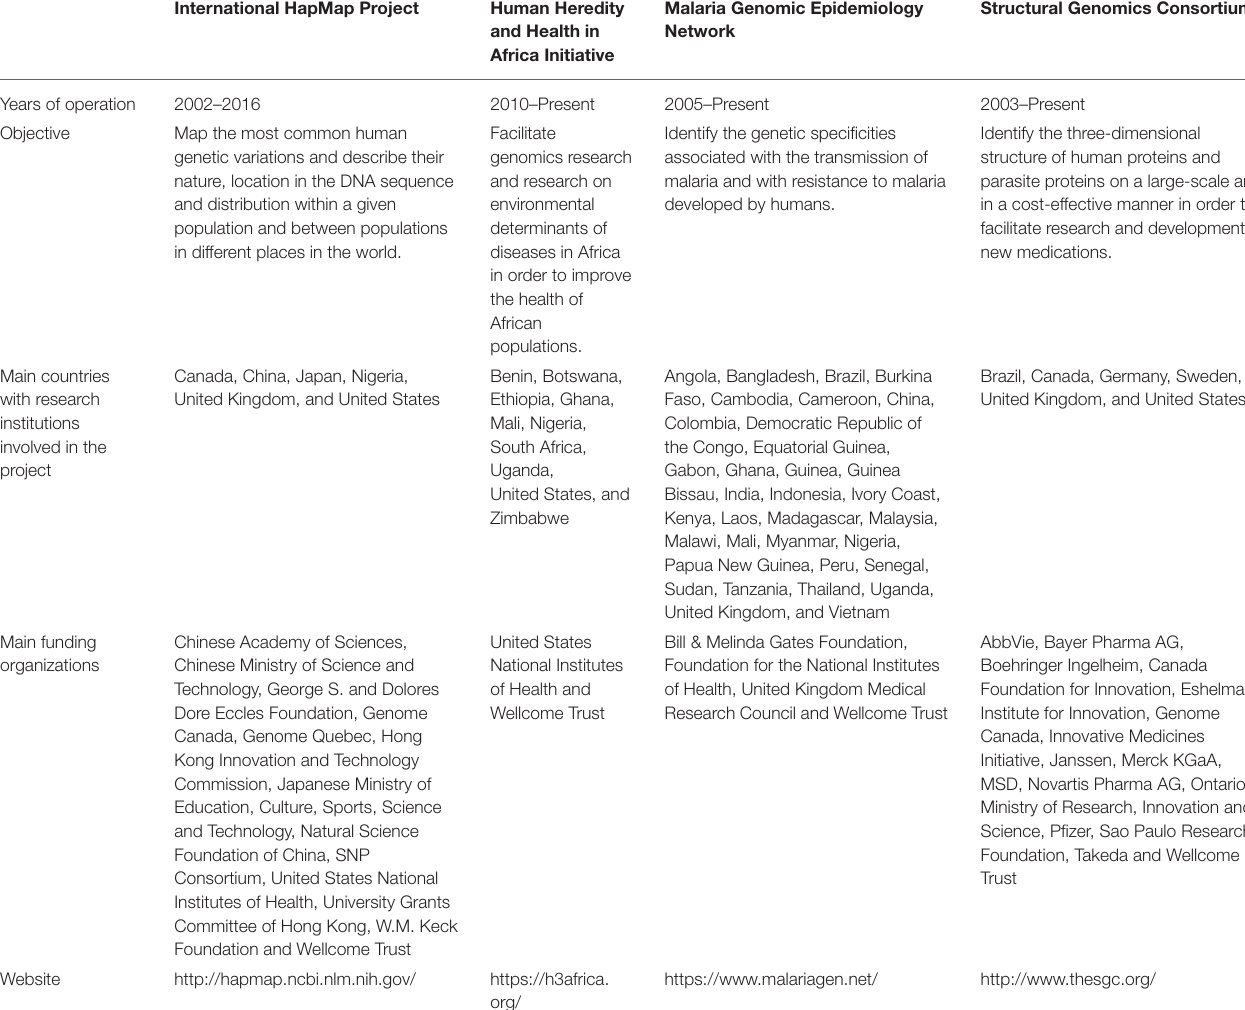
TABLE 1 | International open science genomics